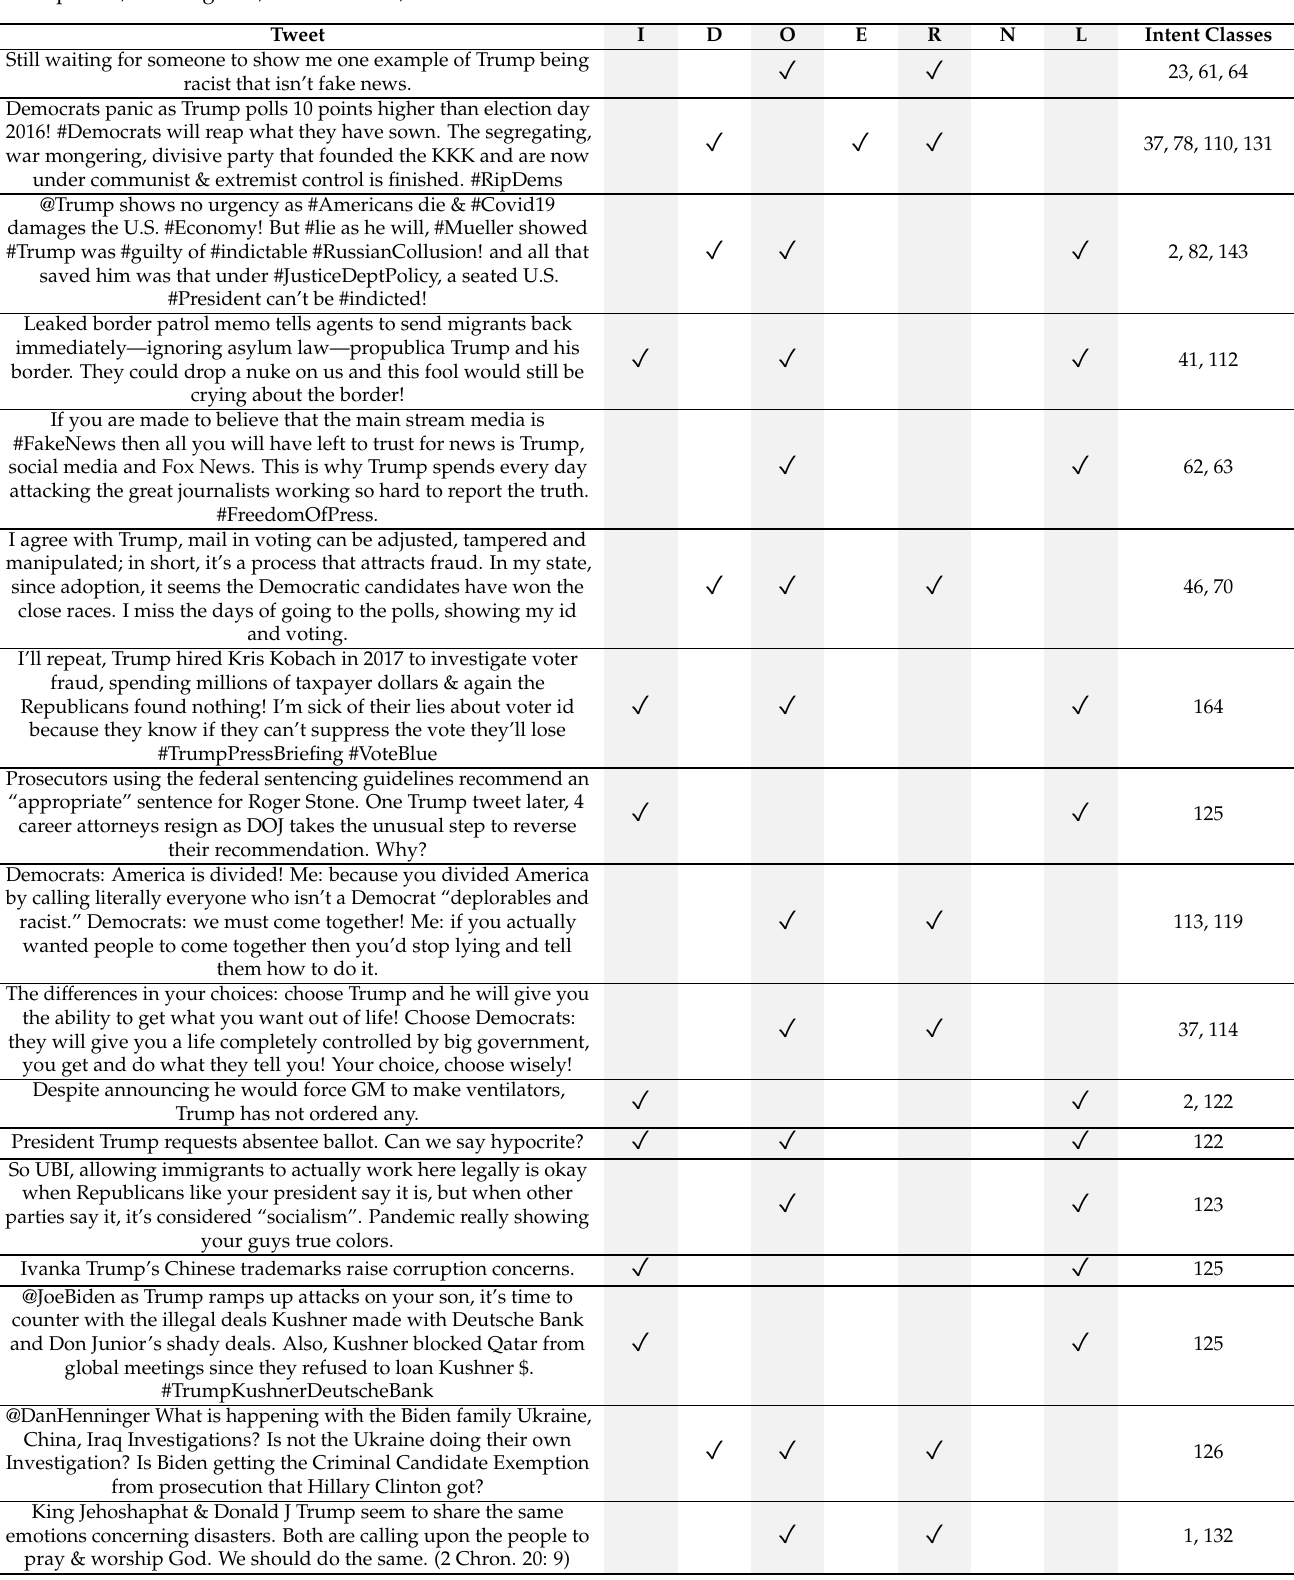
Table 2. Example Tweets and their classes: I stands for information, D for disinformation, O for opinion, E for extreme opinion, R for rightist, N for neutral, and L for leftist.